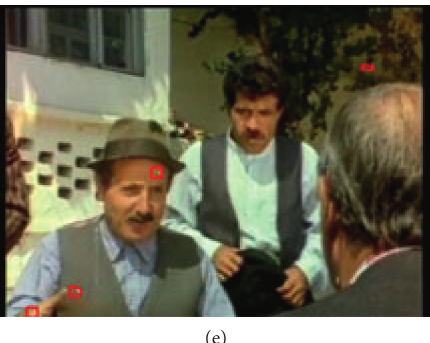
Figure 15: Results of original blotch detection studies for “yesilcam_1” dataset: (a) the HOG feature, (b) the LBP feature, (c) the region matching, (d) the SDI, and (e) the proposed method.